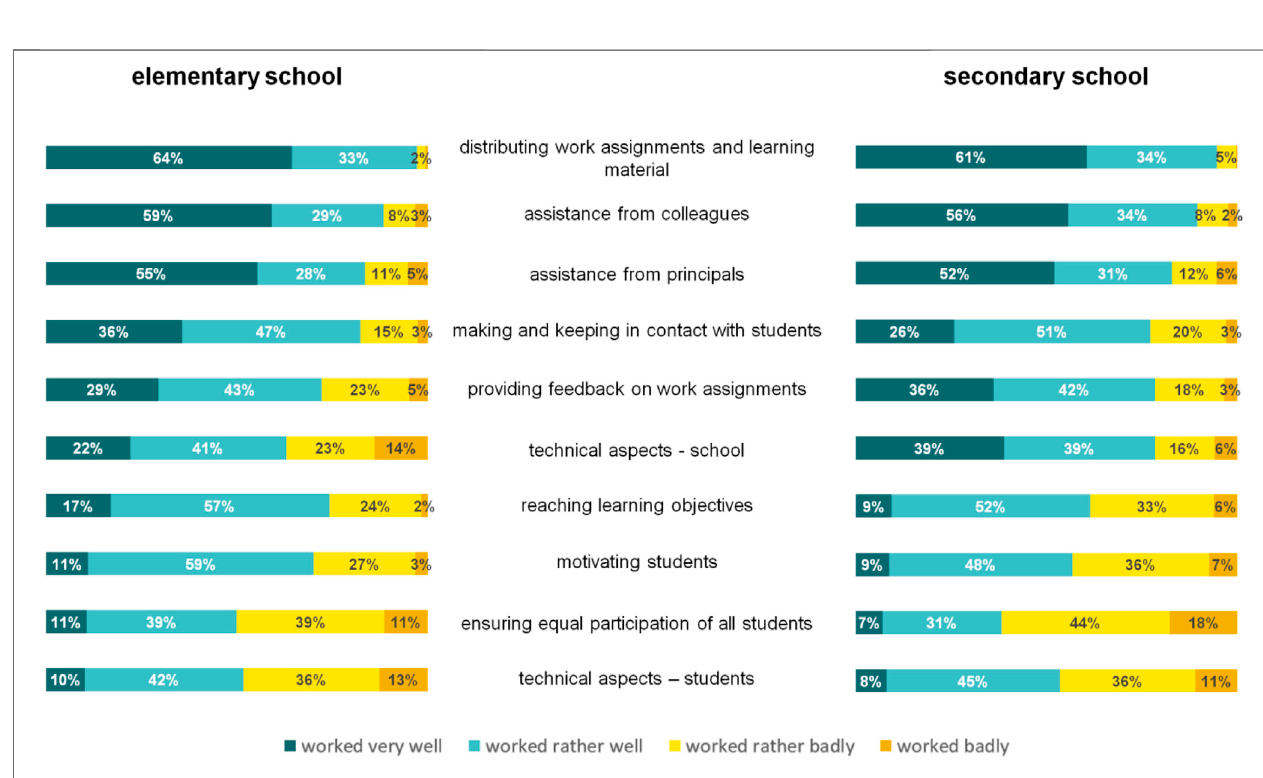
FIGURE 6 | Percentages of teachers handling achievement differences between students in the indicated ways and frequencies.